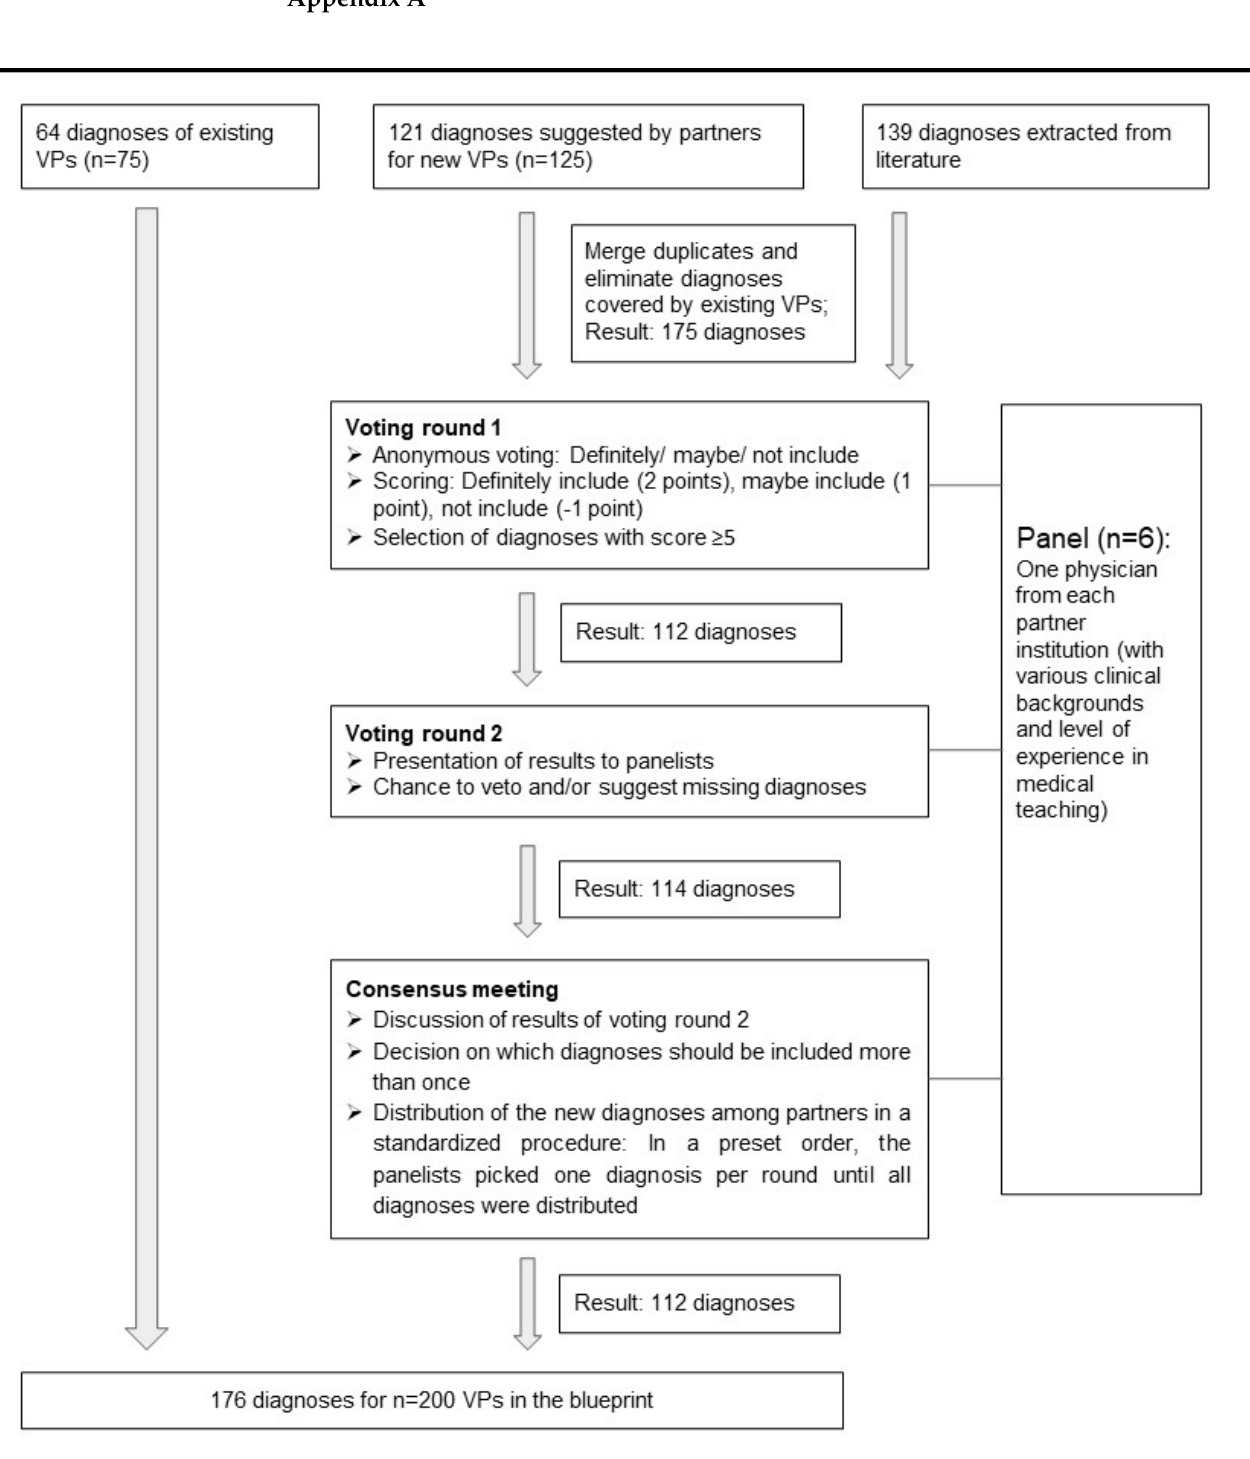
Figure A1. Flowchart of a Delphi-like approach to reach consensus on the final diagnoses to be included in the blueprint.